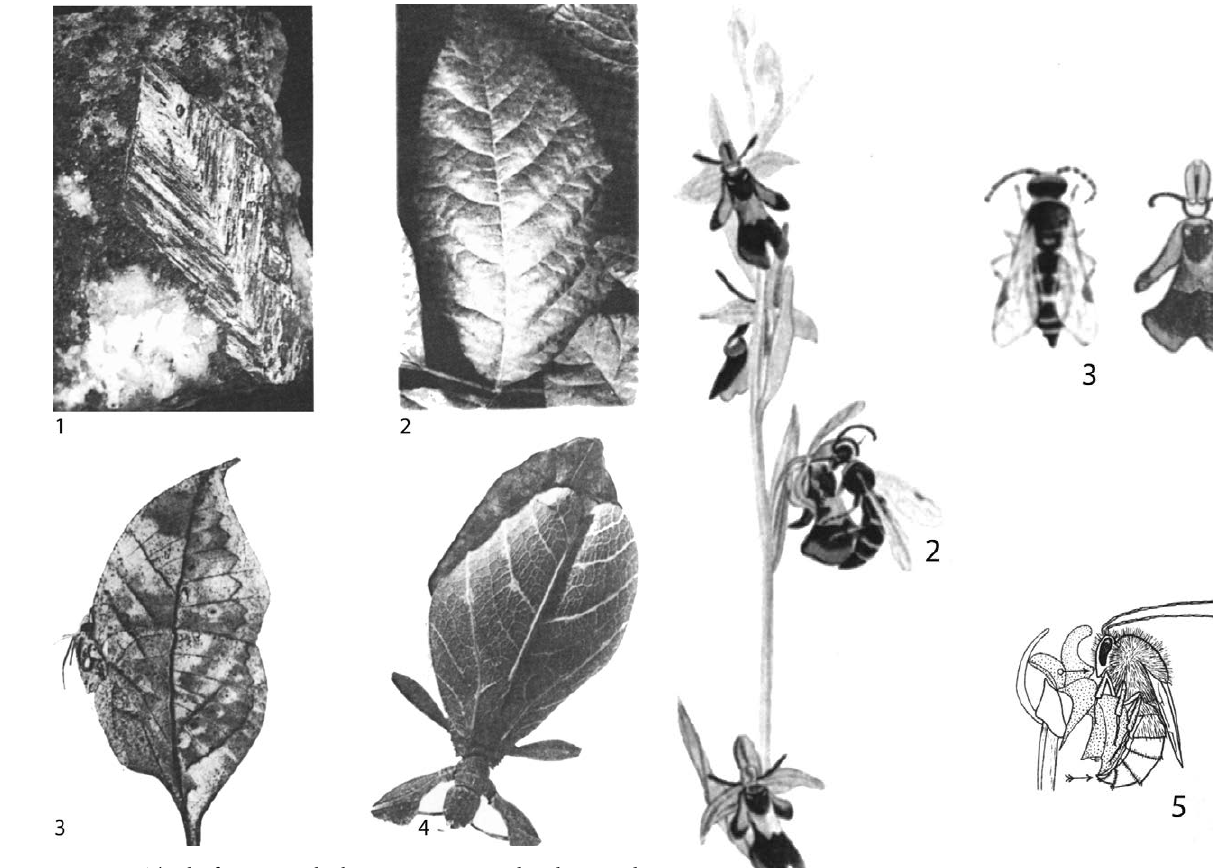
Figure 3. The leaf pattern which occurs in minerals, plants and insects. (1) Mineral, pure bismuth in native state. (2) Plant, leaf of poison ivy Rhus toxicodendron . (3) The leaf-like butterfly Kallima . (4) The leaf-insect Chitoniscus feedjeanus showing leaf-like modifi- cations of the fore-wings, including a midrib and lateral veins. Figure 4. An insect copulates with a flower. Orchid Ophrys insectif- era . (1) Flowering plant. (2) Male of the insect species Gorytes mys- taceous making copulatory movements over the flower. (3) Female of the same species. (4) Flower lip drawn separately to show simi- larity to insect. (5) The flower of the orchid Ophrys bombyliflora covered by the copulating male of the insect Eucera